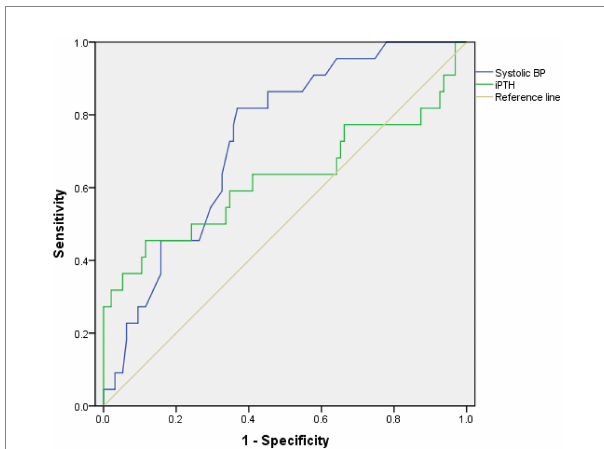
FIGURE 2 Receiver operating characteristic (ROC) curves of systolic BP and iPTH associated with ICH in patients undergoing maintenance hemodialysis.